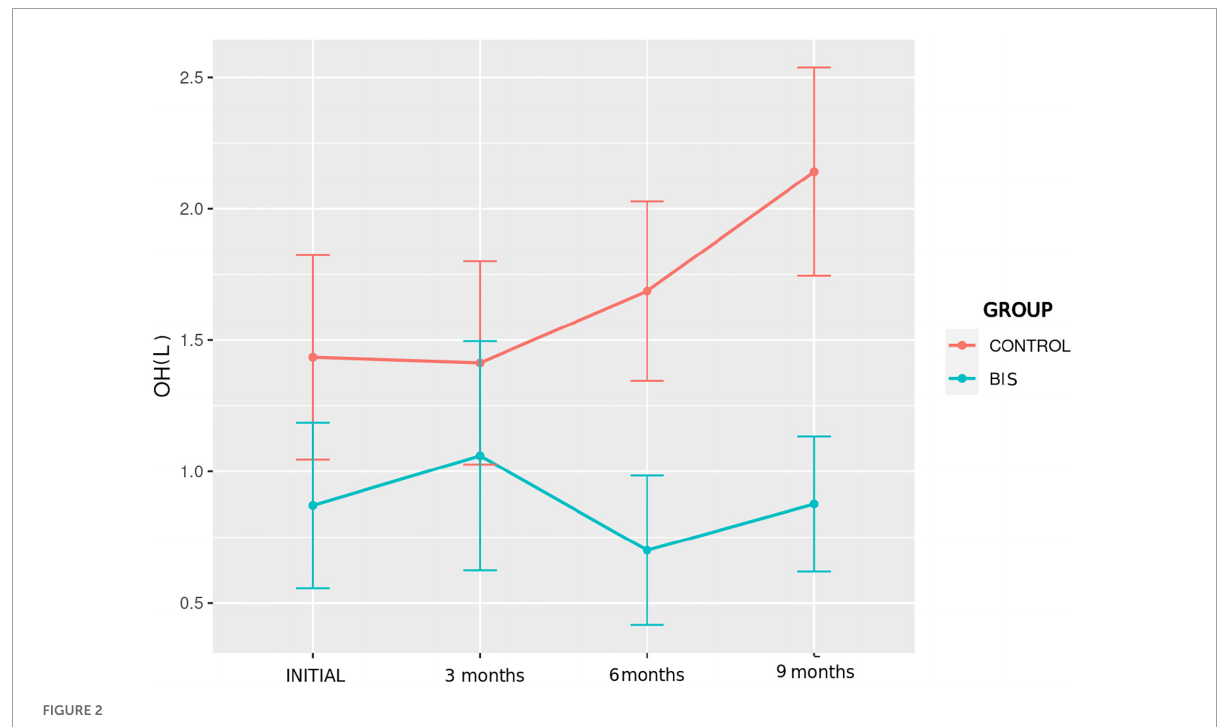
FIGURE2 Evolution of hydration status assessed by OH over time in the study groups.